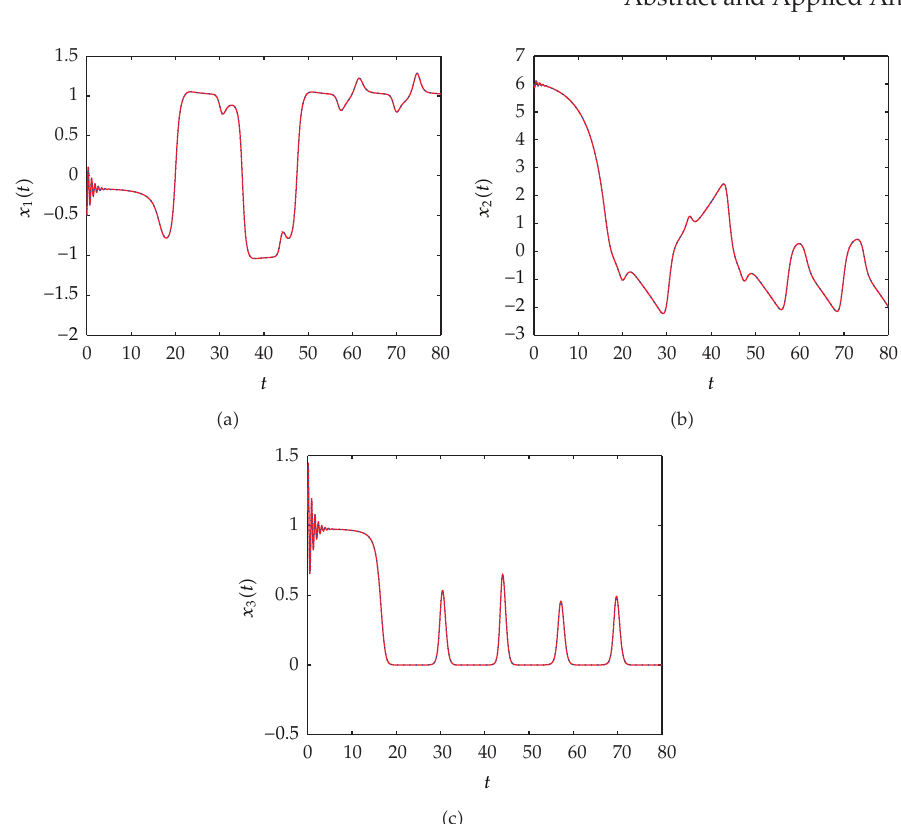
Figure 7: Comparison between the MSRM (cid:2) solid line (cid:3) and ode45 (cid:2) dots (cid:3) results for the Rabinovich- Fabrikant system for a (cid:9) 0 . 1 and b (cid:9) 0 .